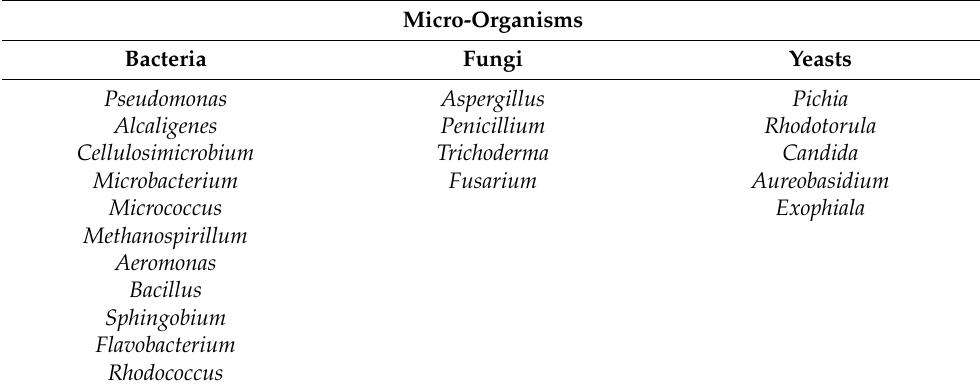
Table 2. Microorganism involved in the xenobiotic degradation process [105–112].